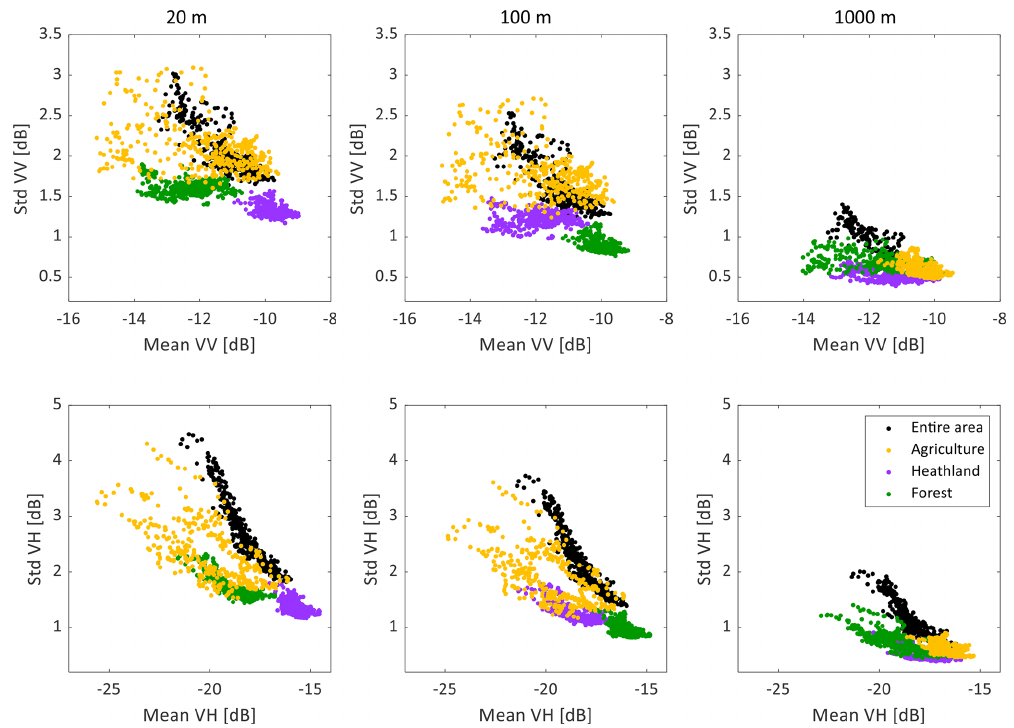
Figure 6. Results of the cluster analysis: relation between standard deviation (Std) and mean for both VV and VH at three different spatial resolutions. The black dots show the relation of the entire area (cluster independent) and coloured dots show the respective relation for each cluster. Table 2. Results of linear regression between VV and VH backscatter at different spatial resolutions at the specific HOBE locations and CRNS-derived soil moisture. See the corresponding scatterplots in the Supplement (Fig.